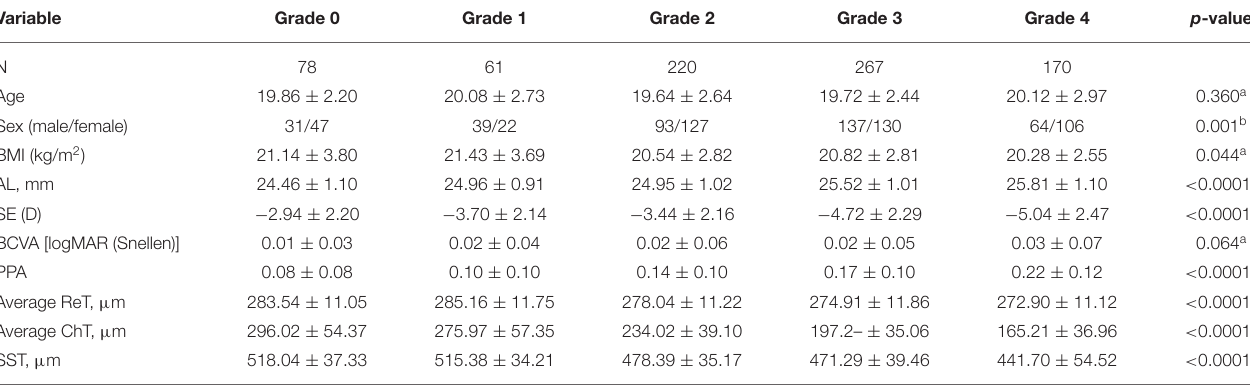
TABLE 3 | Comparisons of characteristics among eyes with different degree of fundus tessellation * . Variable